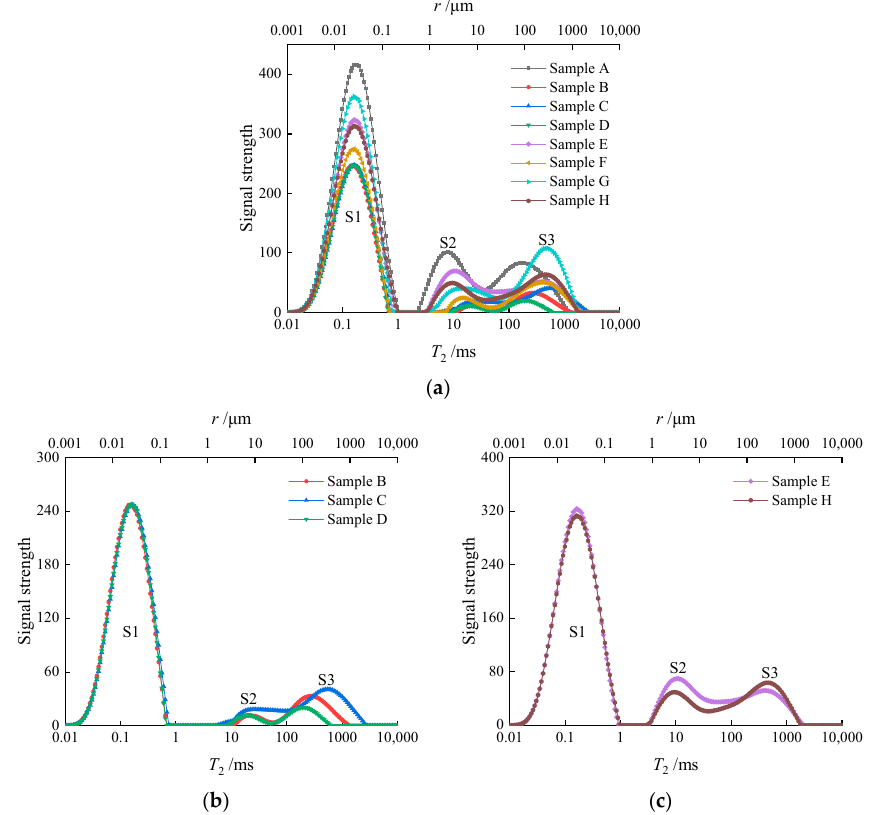
Figure 8. T 2 spectra of saturated coal samples: ( a ) all coal samples; ( b ) samples B, C, and D; ( c ) samples E and H.